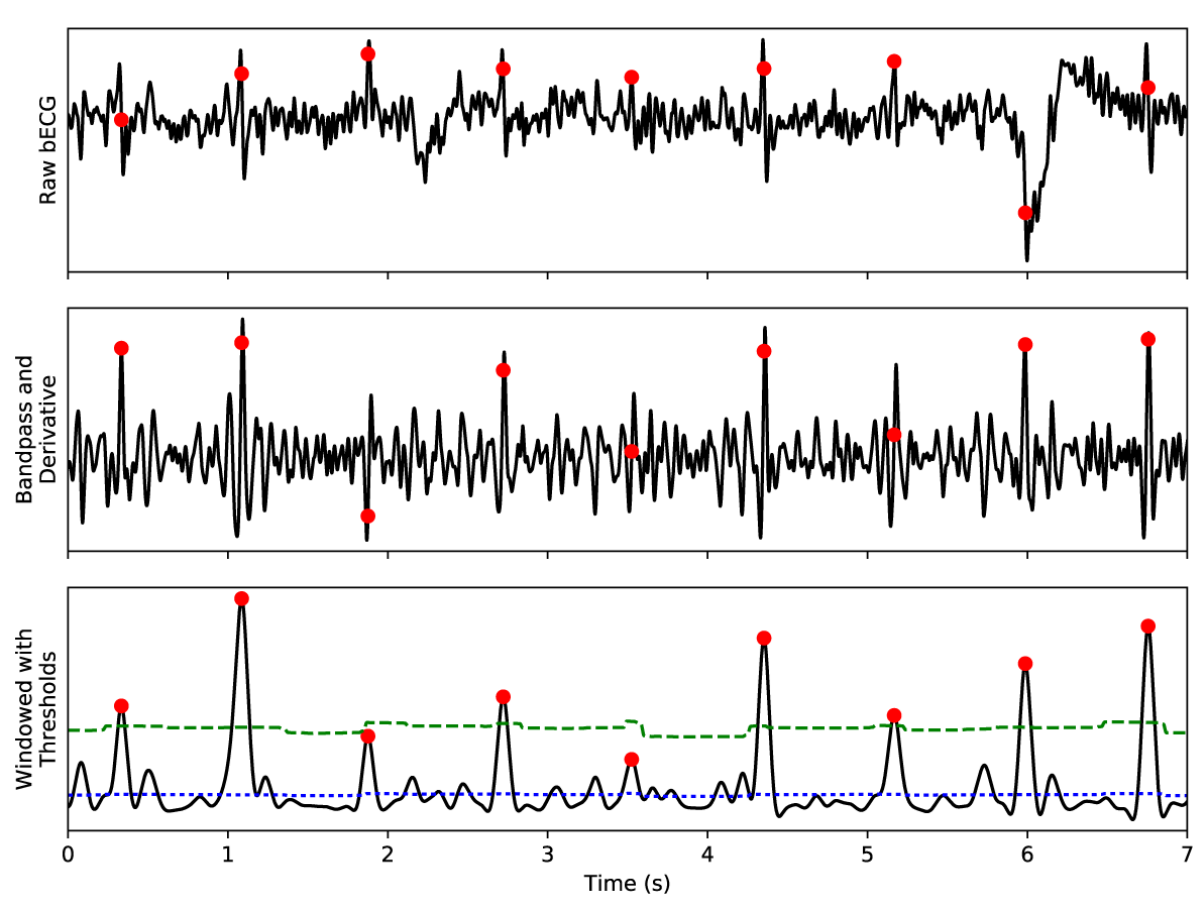
Figure 3. The modified PT algorithm processes the raw ECG signal (top) to isolate QRS complexes for delineation using a bandpass filter and derivative (middle). Dual thresholds (dashed and dotted lines) are calculated using a moving window average and are continually updated (bottom), rather than updating only when a delineated feature is found. The resultant delineations, shown as red circles, are often shifted from the R-peak location, necessitating a subsequent refinement stage. ECG: electrocardiogram; PT: